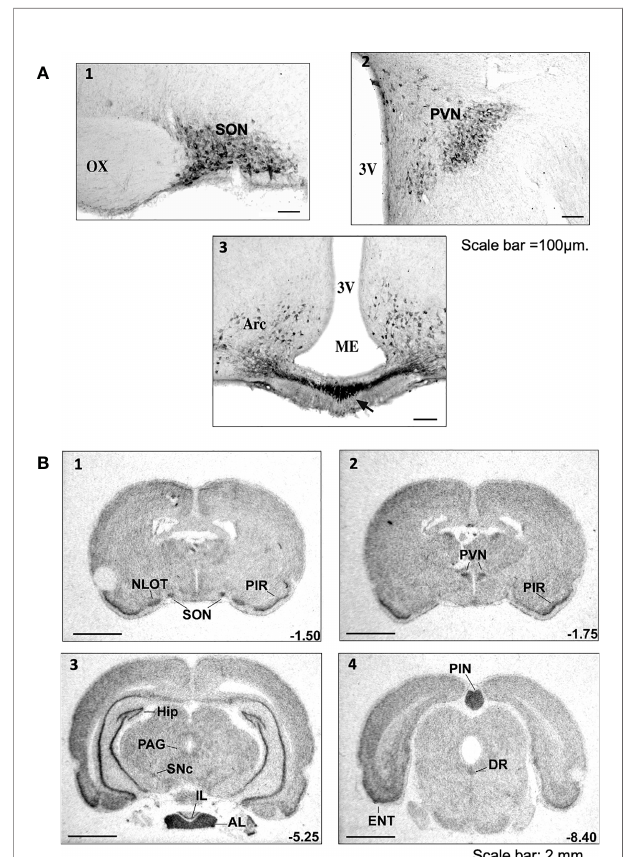
FIGURE 2 | Distribution of apelinergic neurons and apelin-R mRNA in the adult rat brain (A) Coronal sections illustrating the distribution of apelin-containing cell bodies and nerve fi bers in (1) the SON, (2) the PVN and (3) the Arc and ME of colchicine-treated adult rats. In the SON, the apelin-immunoreactive neurons and the nerve fi bers are concentrated mostly in the ventral part of the nucleus. In the PVN, apelin-positive cell bodies and nerve fi bers are found mostly in the magnocellular part of the nucleus. Numerous neuronal cell bodies were observed within the Arc, together with a higher density of nerve fi bers in the internal layer of ME than in the external layer. Scale bar =100 µm. Figure adapted from Ref. (11, 54) with permission from the copyright holders. (B) Distribution of the rat ApelinR mRNA expression in the adult rat brain. The fi gures were scanned directly from the X-ray fi lm. Representative frontal sections, at anteriorities determined from the bregma indicated in the lower right corner, from 1 to 4, were hybridized with the ApelinR antisense cRNA probe. Scale bar: 2 mm. Figure adapted from Ref. (11) with permission from the copyright holders. AL, anterior lobe of the pituitary gland; Arc, arcuate nucleus of the hypothalamus; DR, dorsal raphe nucleus; ENT, entorhinal cortex; HIP, hippocampus; IL, intermediate lobe of the pituitary gland; ME, median eminence; NLOT, nucleus of the lateral olfactory tract; OX, optic chiasma; PAG, periaqueductal gray matter; PIN, pineal gland; PIR, piriform cortex; PVN, paraventricular nucleus of the hypothalamus; SNc, pars compacta of the substantia nigra; SON, supraoptic nucleus; 3V, third